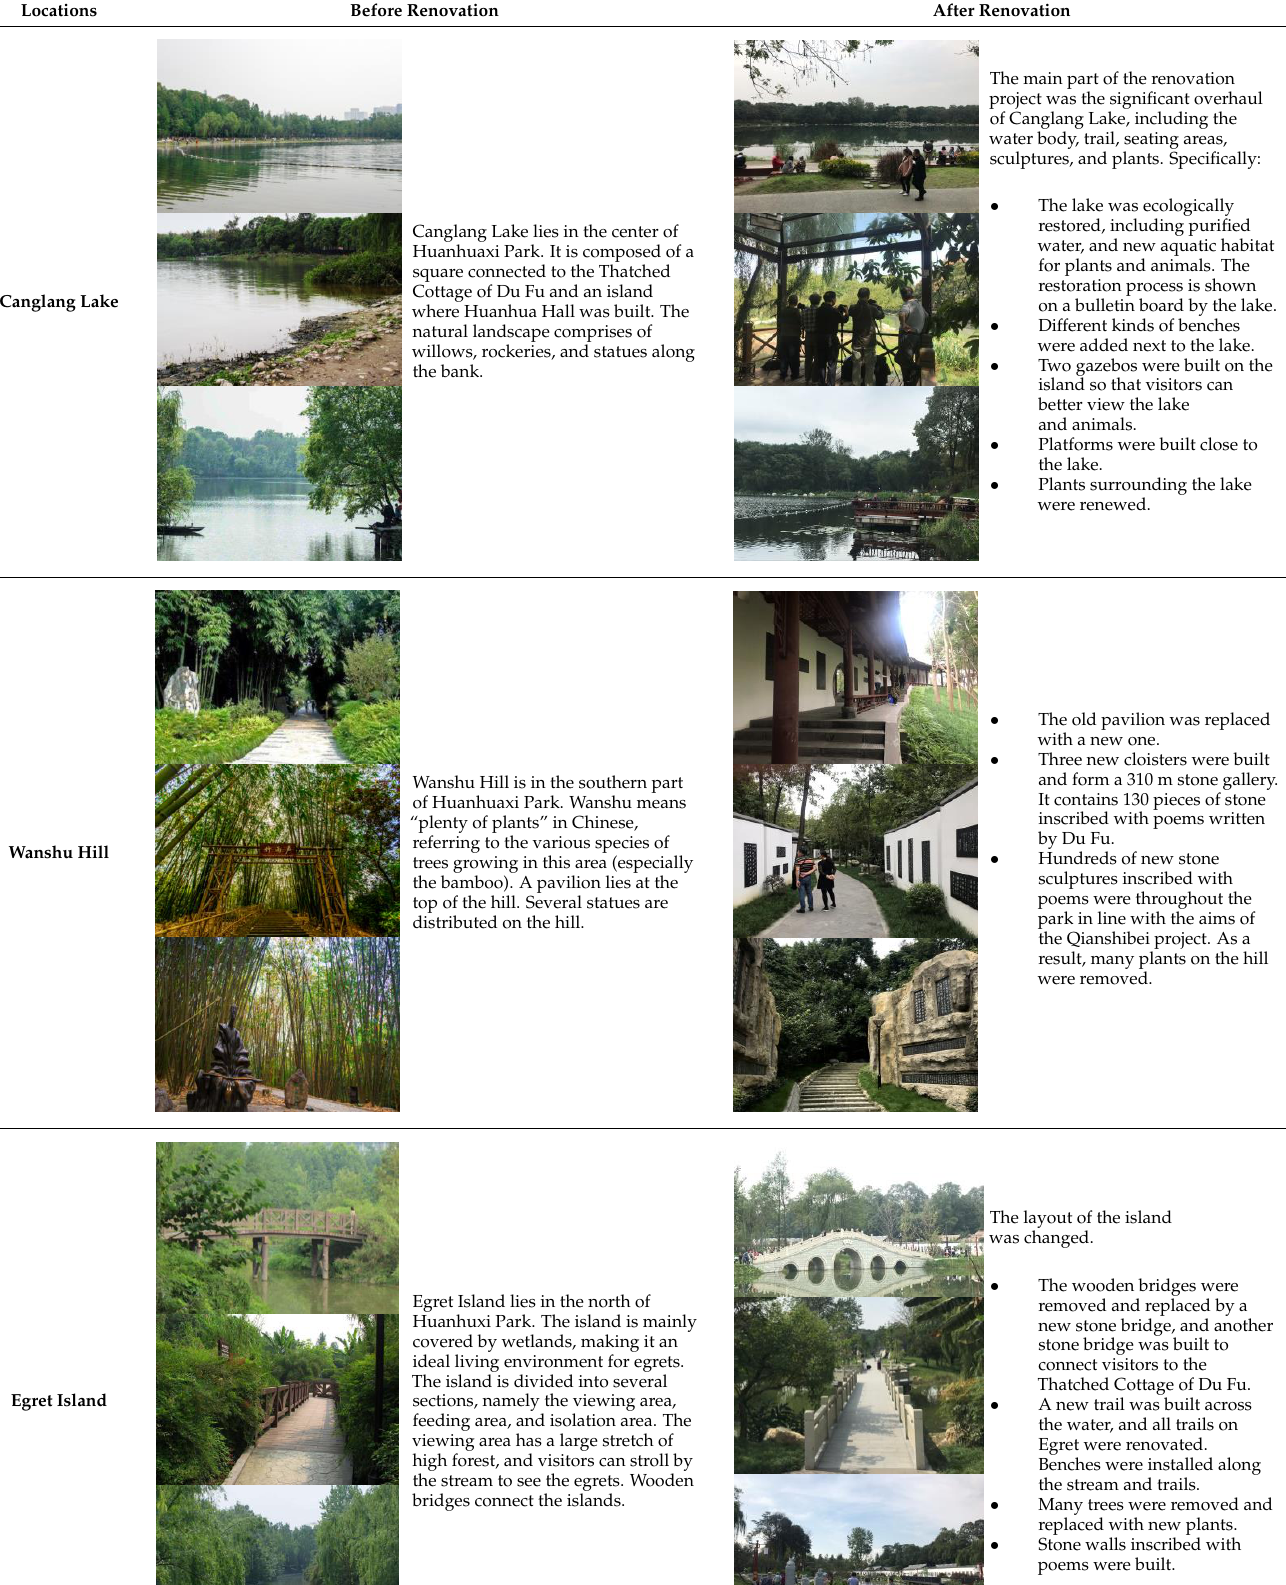
Table 1. Main renovated